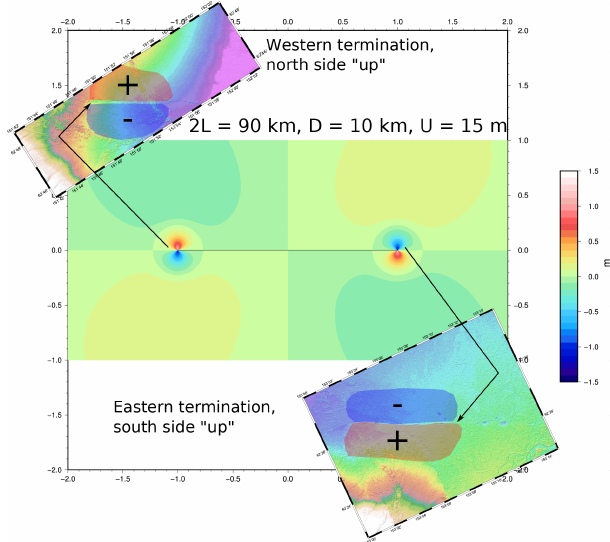
Figure 10. Elastic dislocation model for a 90km fault segment (half-length, L = 45km), 10km deep, reaching the surface, with 15m average slip. Contours show vertical displacements (co- seismic) for such a slip event. Fault is vertical. Also shown is the topography around the two scarps at the terminations of the 90km fault